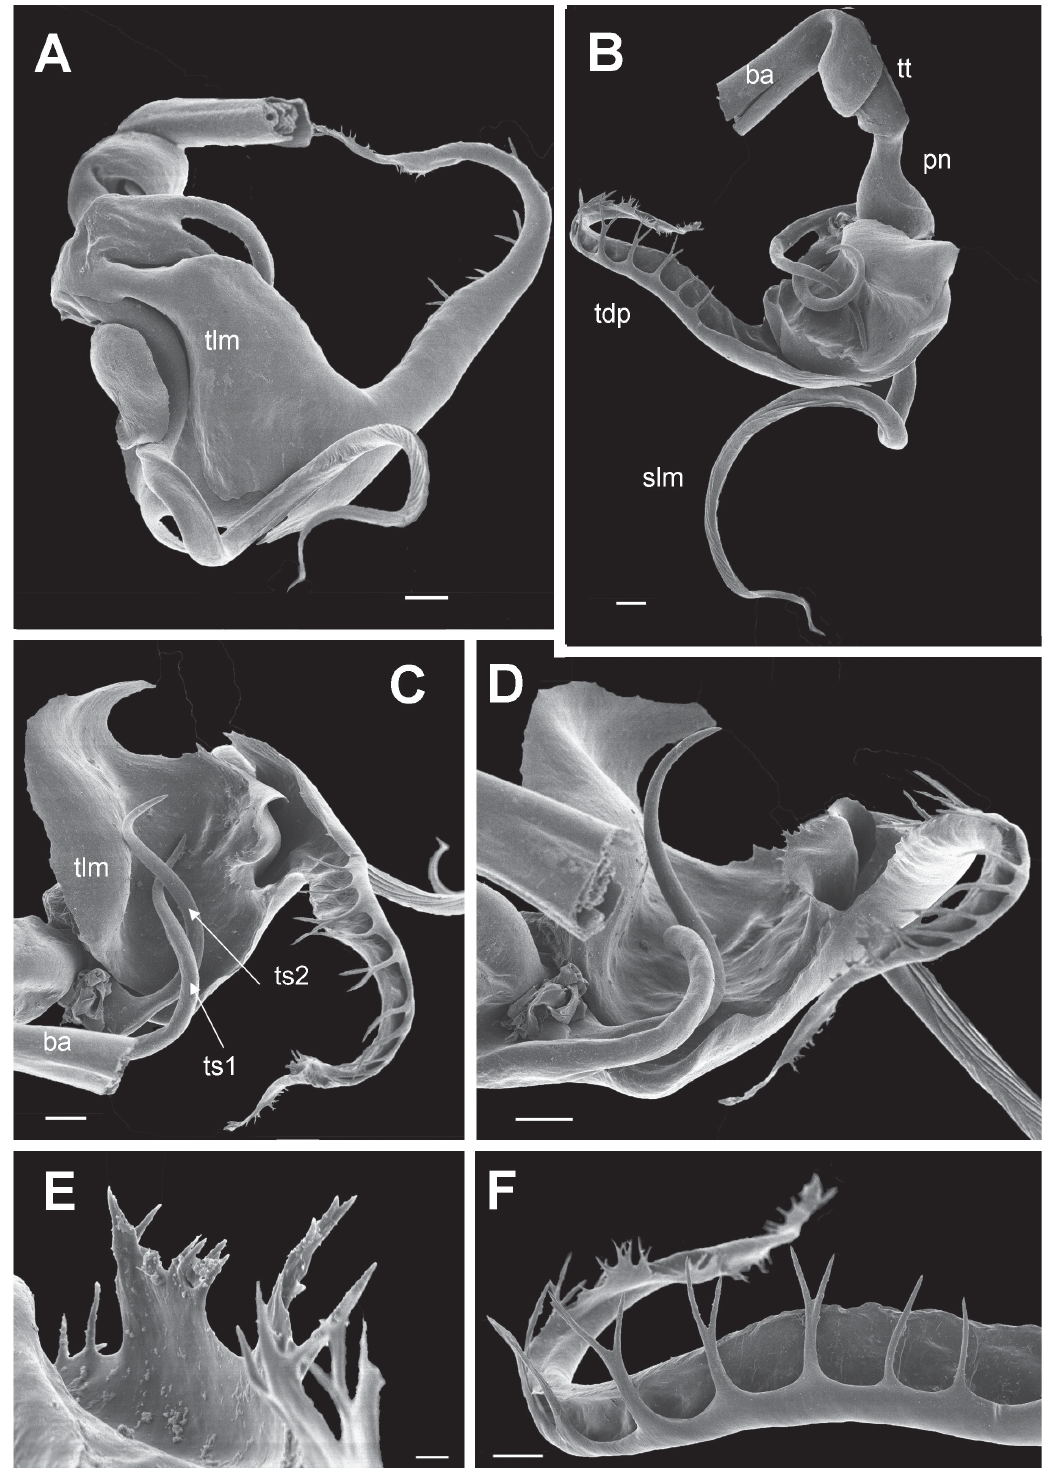
Fig. 6. Yia geminispina gen. et sp. nov., holotype. Left gonopod telopodite. A . Posterior, slightly basal view. B . Anterior, slightly basal view. C . Anterior, slightly basal view. D. Basal view. E–F . Detail of margin of telomere. F . Tip of telomere. Abbreviations: ba = basomere, pn = post-torsal narrowing, slm = solenomere, tdp = telomeral distal process, tlm = telomere, ts1 , ts2 = telomeral spines, tt = torsotope. Scales: A–D = 0.1 mm; F = 0.05 mm; E = 0.005